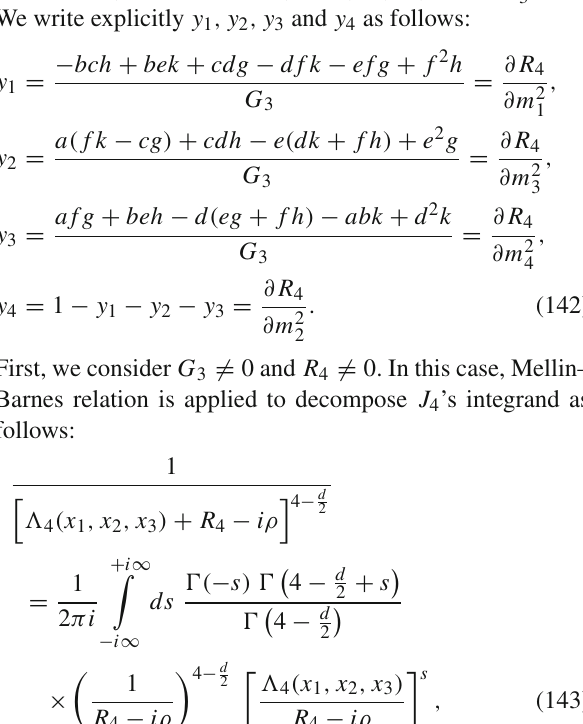
Table 1 The coefficients A i , B i , C i , D i , E i , F